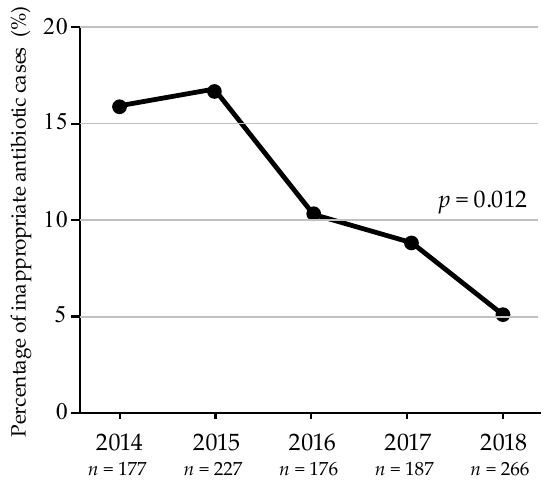
Figure 1. The percentage of inappropriate antibiotic cases among the patients audited by pharmacists between 2014 and